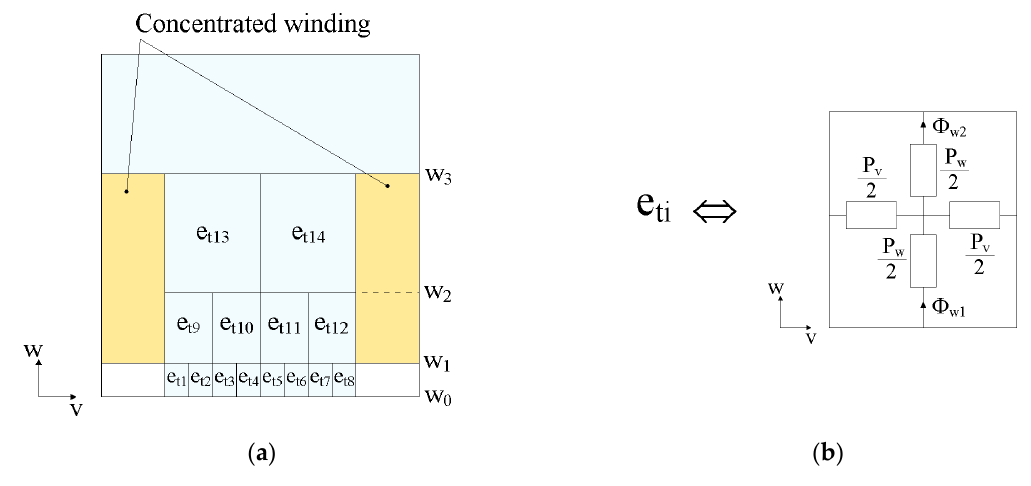
Figure 26. Open-circuit radial flux linkage calculation.